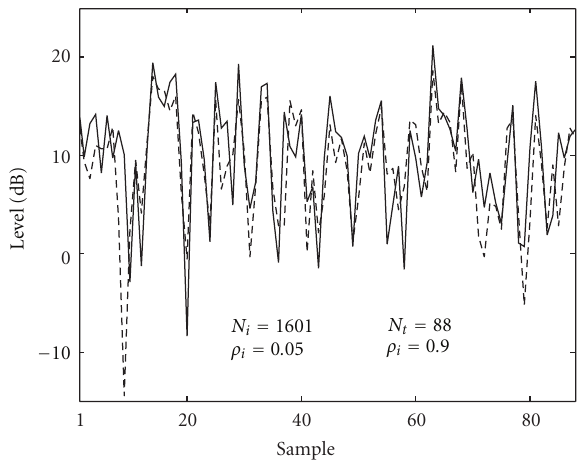
Figure 5: Remaining sequences after selection, with ρ t = 0 . 9. Solid line is channel 1 and broken line is channel 2.